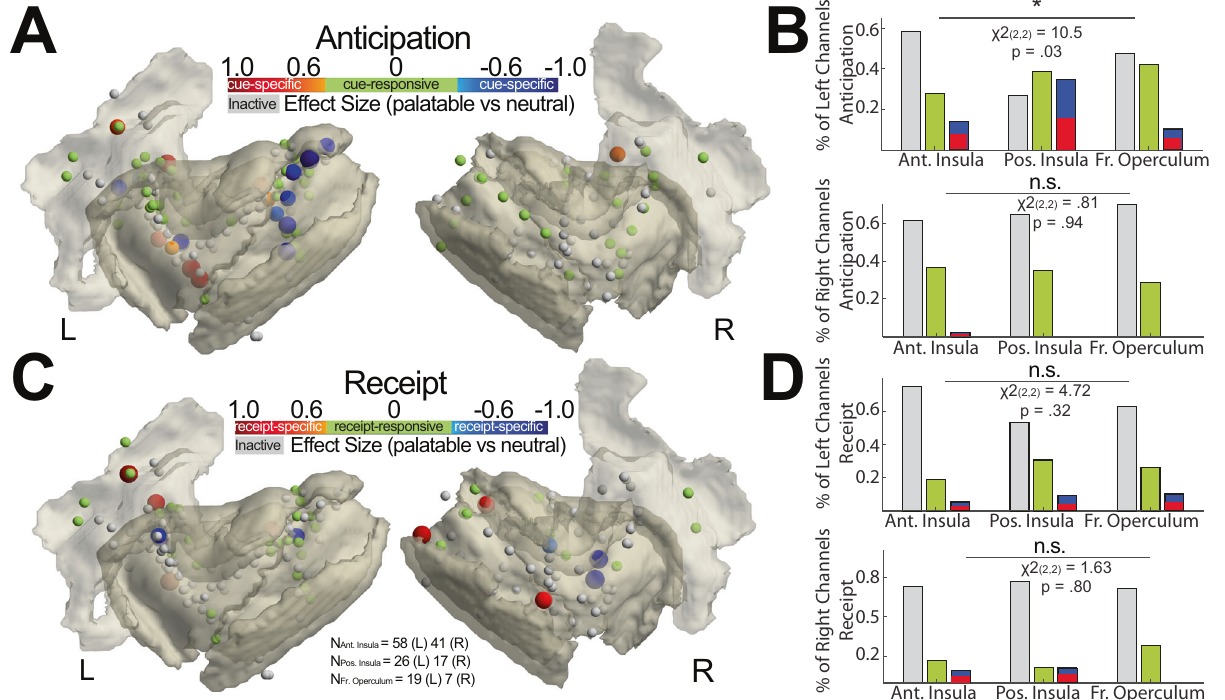
Fig. 2 Topographic differences in insular and frontal opercular neural activity when anticipating and receiving task solutions. A Site-by-site differences in anticipatory neural activity. Effect size between the anticipatory response to palatable vs. neutral solution is shown per electrode. Shades of red indicate signi fi cantly greater response in palatable trials whereas shades of blue indicate signi fi cantly greater response in taste-neutral trials. Green indicates a signi fi cant increase in activity from pre-cue baseline activity, but no difference between palatable or neutral conditions (cue-responsive but not cue- speci fi c). Gray indicates activity was not different from pre-cue baseline activity (inactive). B Proportion of inactive (gray bar), responsive but not speci fi c (green bar), and speci fi c (blue/red bar) electrodes during anticipation strati fi ed by anatomical location and sidedness. Chi-square proportional test was employed. C , D the Same set of plots as in ( A , B ) showing site-by-site differences in receipt neural activity. Chi-square proportional test was